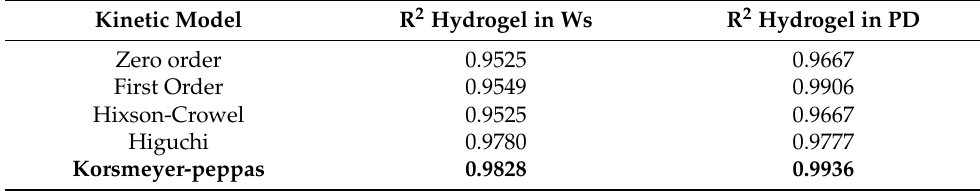
Table 3. Values of coefficients of determination obtained for all the kinetic models used.